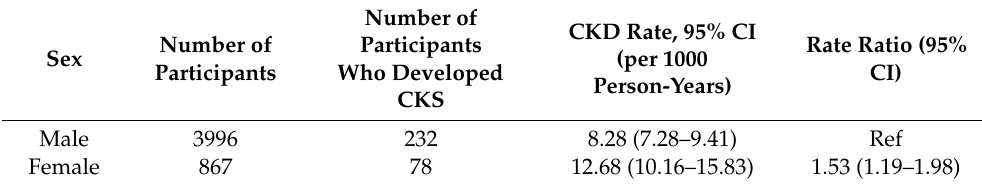
Table 4. Comparison of chronic kidney disease (CKD) rates of by Table 4 . Comparison of chronic kidney disease (CKD) rates of by sex.